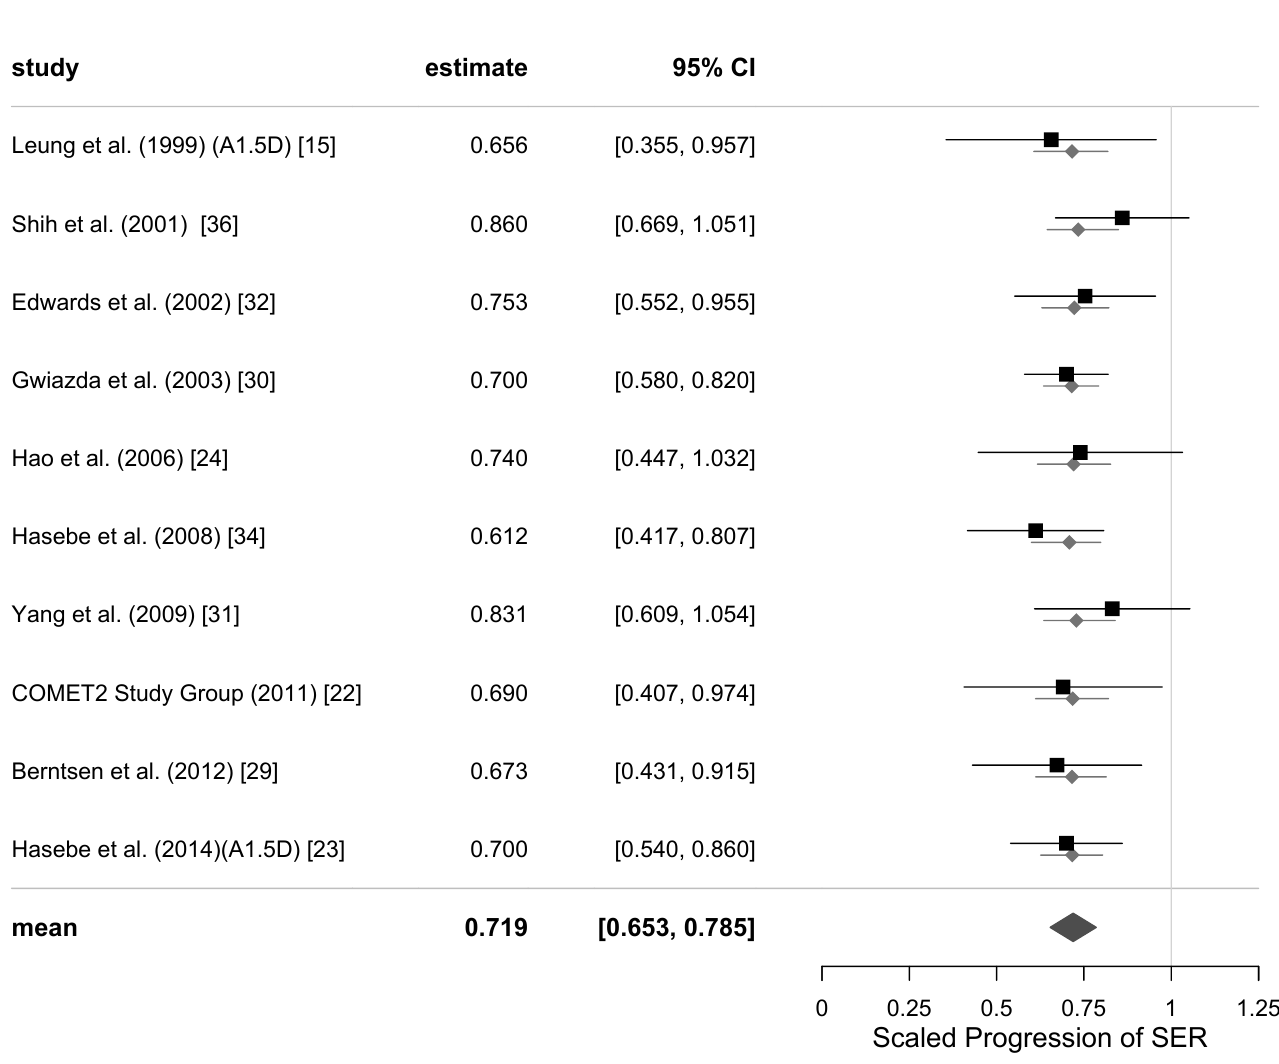
Figure 2. Forest plot for the scaled progression of sphere equivalent refraction (SER) at 12-months follow-up with all the trials included. The first column of the forest plots references the source of the data, the second column gives the mean effect size obtained in the study expressed as a scaled progression, the third column gives the 95% credibility interval associated with the mean effect size. The last column shows the estimate of the mean effect size and the associated credibility intervals for the mean effect of each trial (black squares and lines) and the shrinkage estimates (grey diamonds and lines), which are corresponding estimates adjusted relative to µ and τ . The centre of the large diamond in the final row corresponds to the estimated mean effect size of all the trials included in the meta-analysis, and its width corresponds to the calculated 95% credibility